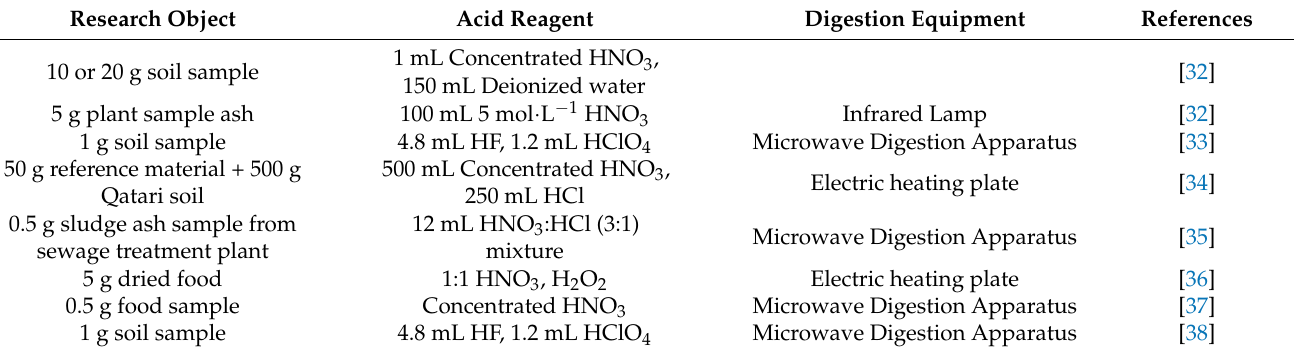
Table 4. Digestion methods applied to the analysis of 90 Sr, 239 Pu, and 240 Pu in the